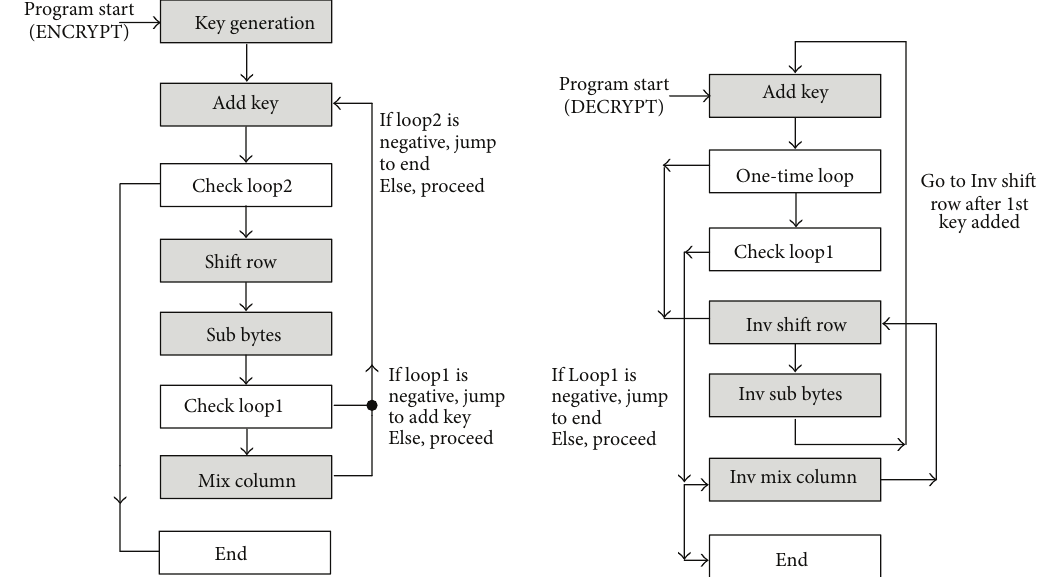
Figure 21: The CISA AES encryption and decryption program flowchart and structure.